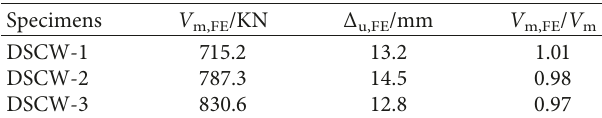
Table 5: Lateral load resisting capacity and displacement of FE